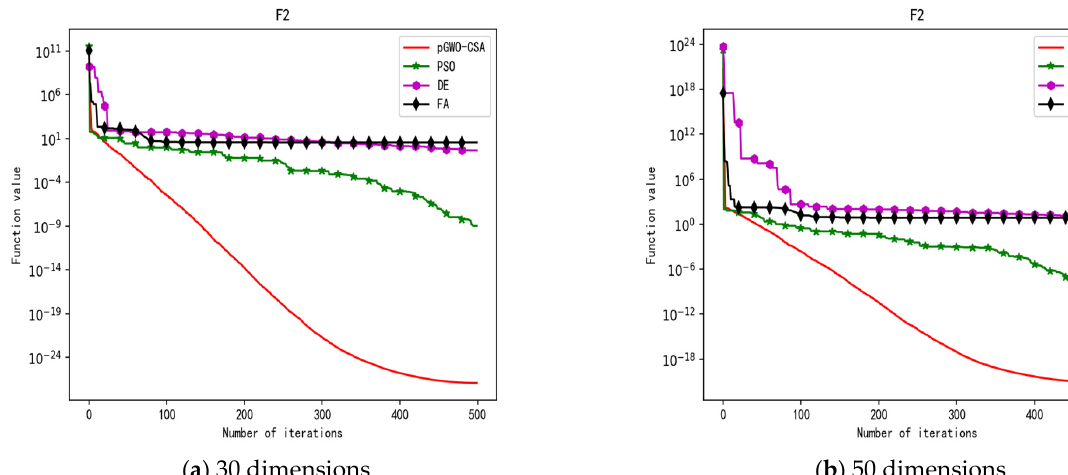
Figure 6. Convergence curve of test function F2.